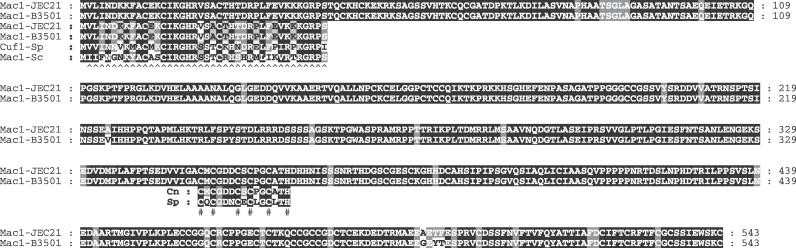
The C. neoformans Mac1 Protein Is PolymorphicTranslated amino acid sequences for Mac1 from strains B3501α and JEC21α (congenic to B3502a) are depicted. CNG02270 contains a copper-fist DNA binding domain at the N-terminus that is conserved between copper-regulating transcription factors, such as Mac1 of S. cerevisiae and Cuf1 of S. pombe. It also shares a copper-binding motif at the C-terminal region with S. pombe Cuf1 (328–342aa) that is important for activity.^, sequences underlined with this mark are the predicted copper-Fist DNA binding domain.#, cysteine and histidine residues conserved between Cuf1 of S. pombe and Mac1 of C. neoformans.
Cn, C. neoformans; Sc, S. cerevisiae; Sp, S. pombe.